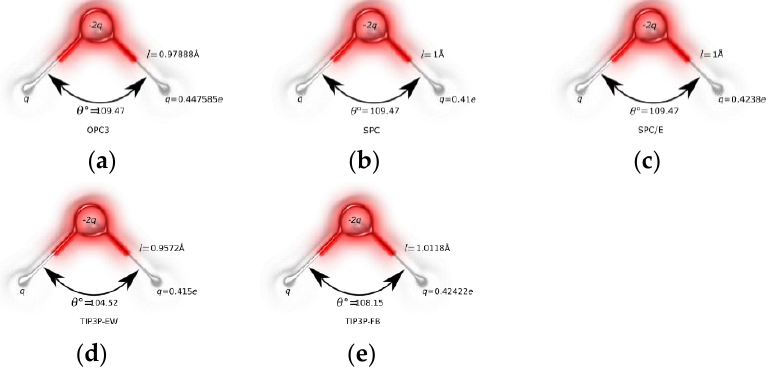
Table 1. LJ parameters and atomic charges employed for water molecules in this work.